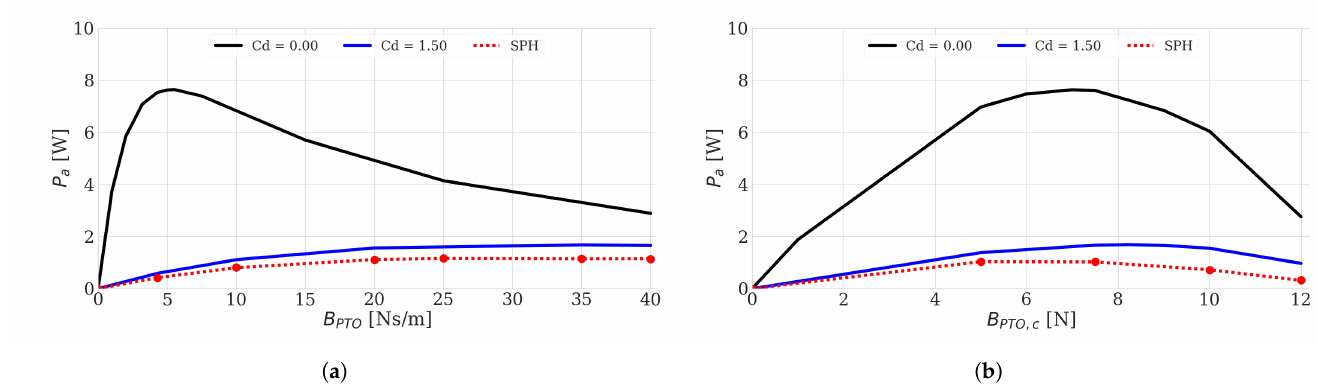
Figure 10. Average absorbed power of cylinder2 with ( a ) a linear damping PTO system and ( b ) a Coulomb damping PTO system for a range of PTO system damping coefficients, calculated with linear potential flow theory with (i) C d = 0.00, (ii) C d = 1.50 and (iii) with DualSPHysics— H = 0.15 m, T = 1.2 s.